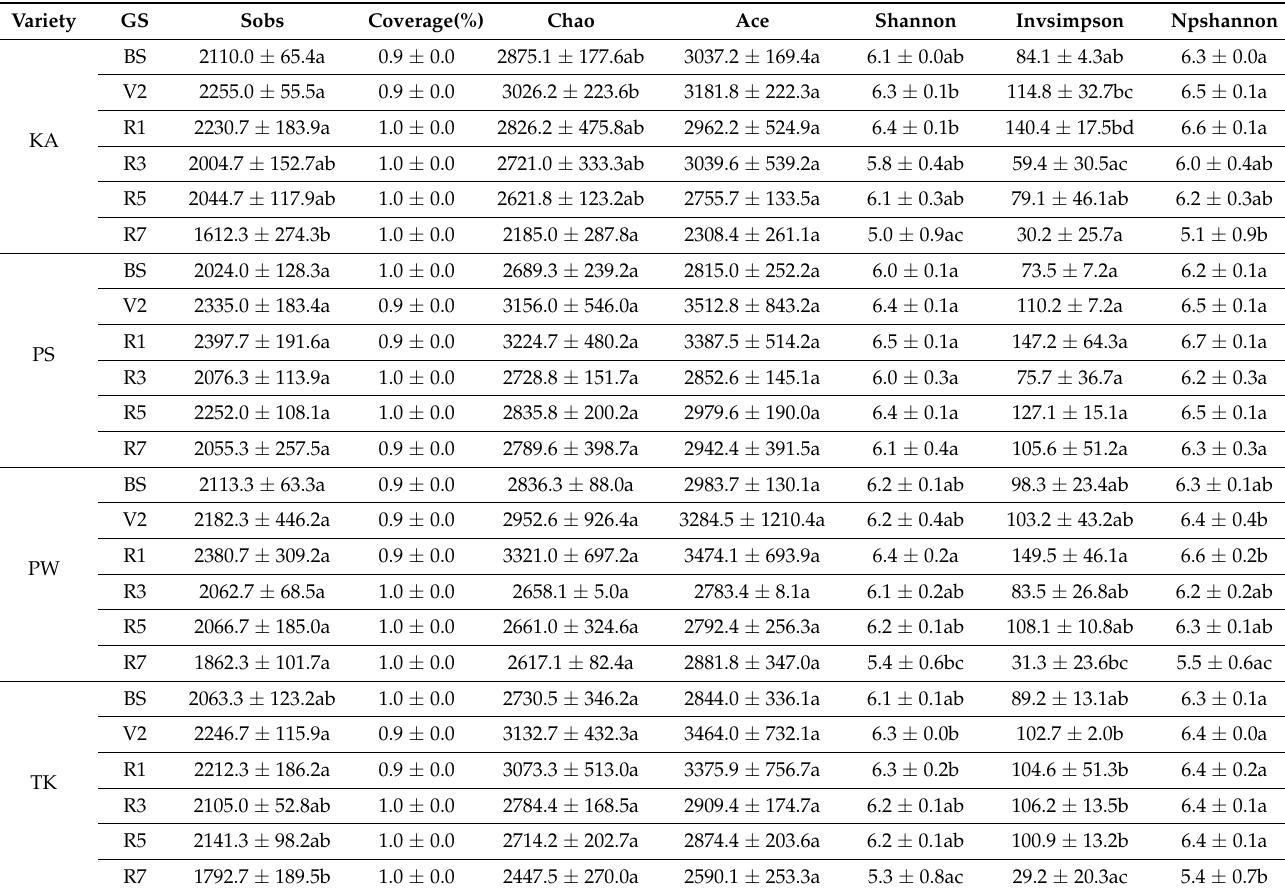
Table 1. Diversity indices of bacterial community in the rhizosphere soil of 4 varieties of soybean.